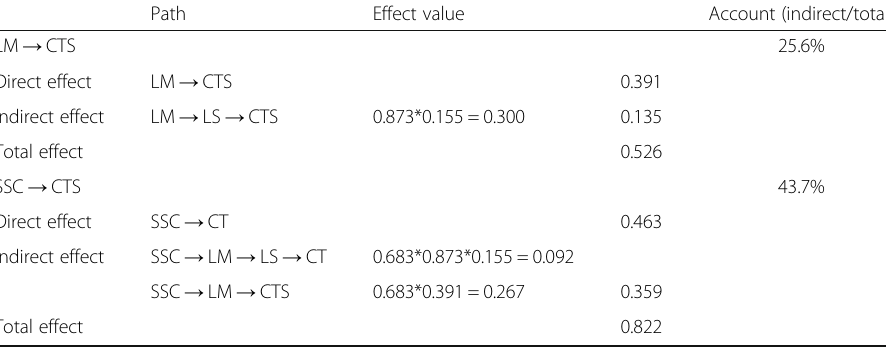
Table 4 Analysis of indirect and total effects between key